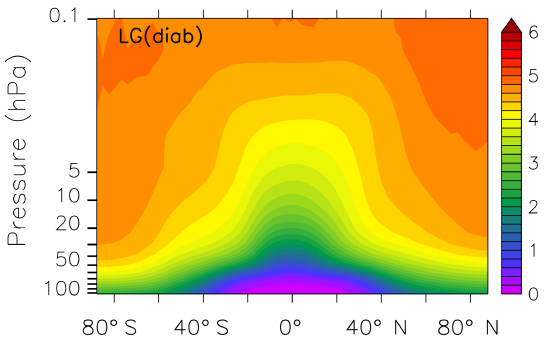
Figure 10. Normalised age spectra (tropics and poles) of the years 2006–2010 between 50 and 0.1hPa from the LG(diab) simulation. The data points represent the normalised frequency per half-year bin.